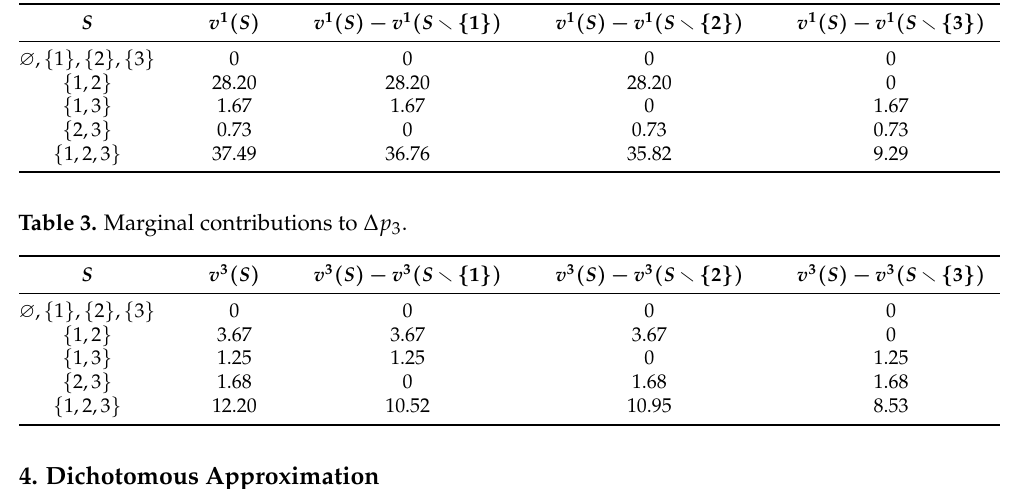
Table 2. Marginal contributions to ∆ p 1 .